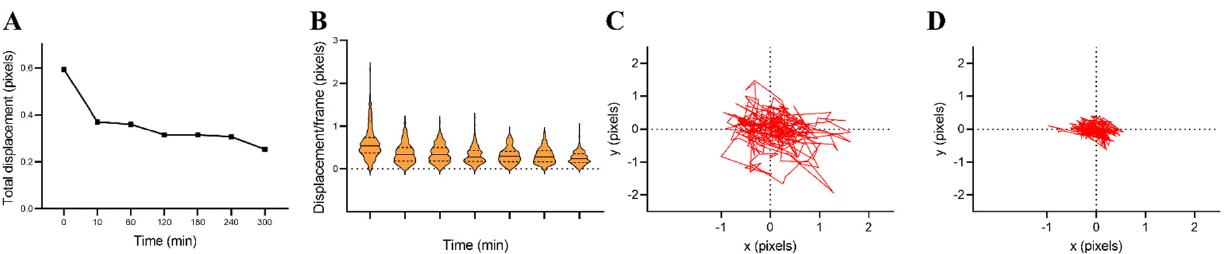
Figure 13. E ff ect of the antifungal fl uconazole (1 µg/mL) on the cellular nanomotion of cell 17 with C. albicans CAF2 − 1. ( A ) Total displacements (pixels) as a function of time for cell 17. ( B ) Distribution of the displacement/frame as a function of time for cell 17. ( C ) X − y displacement at the time point 0 min for cell 17. ( D ) X − y displacement at the time point 300 min for cell 17.